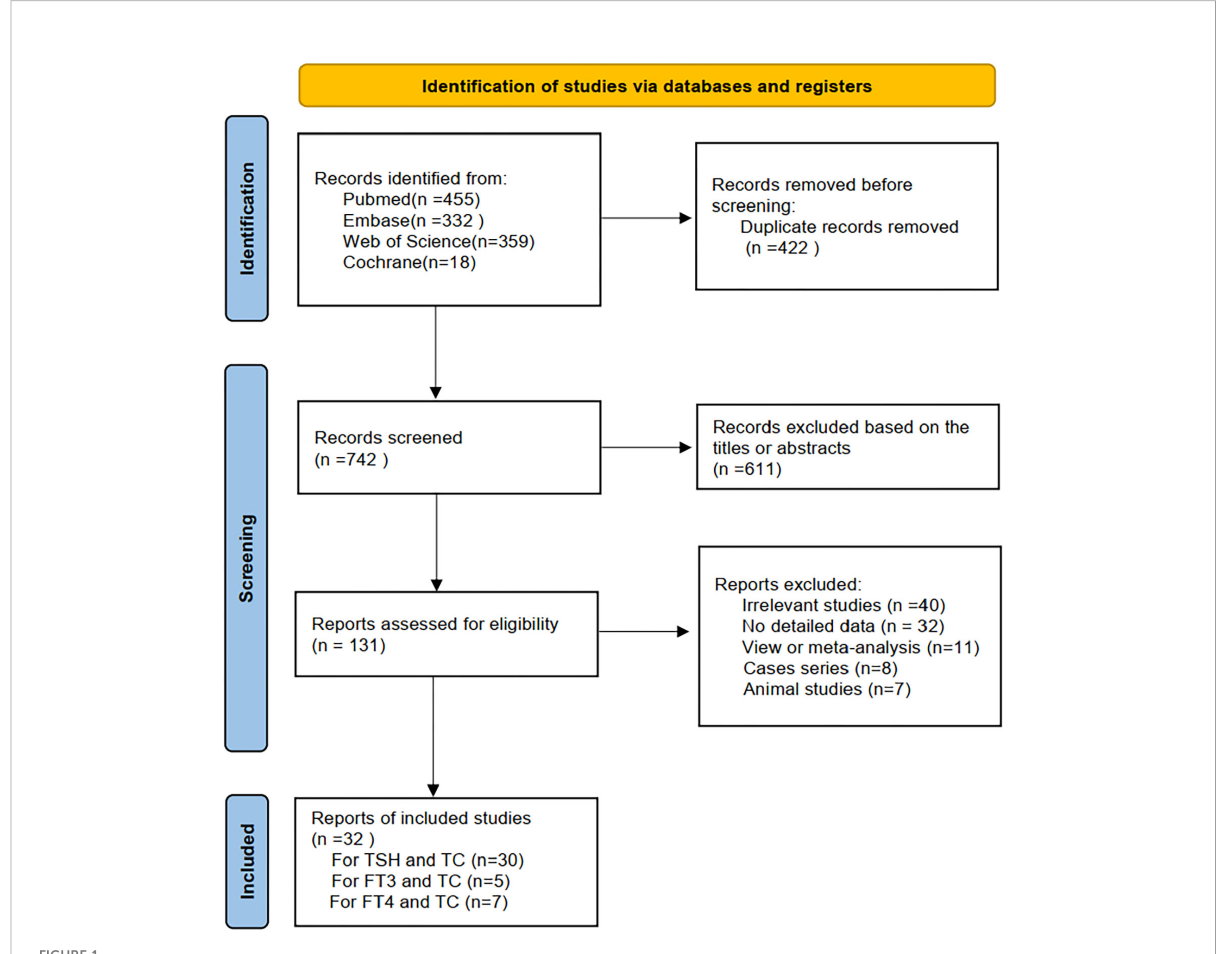
FIGURE 1 Flow diagram of study selection